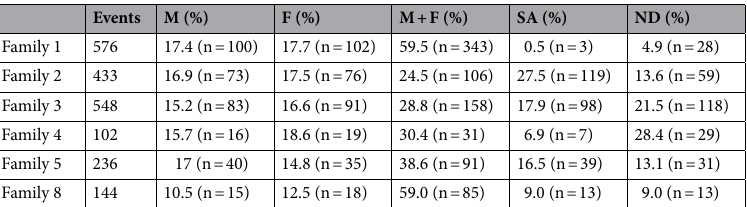
Table 2. Total number of parental care events recorded in each monitored porcupine family. The frequency of parental care occurrence by the adult male (M), the adult female (F), sub-adults (SA), and the adult male and female together (M + F) in each family are reported. Numbers of parental care events performed by undetermined individuals (ND) are also reported.